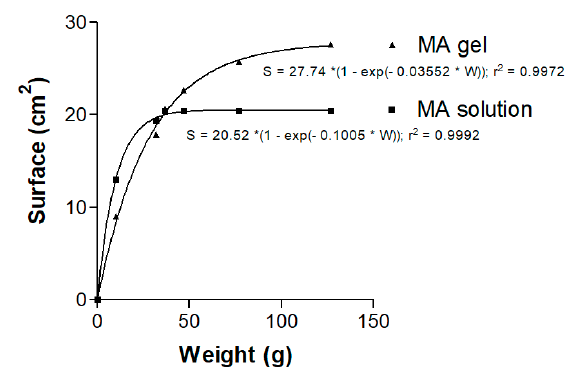
Figure 5. Spreadability graphic and first-order kinetic model equations for the MA gel and MA solution.